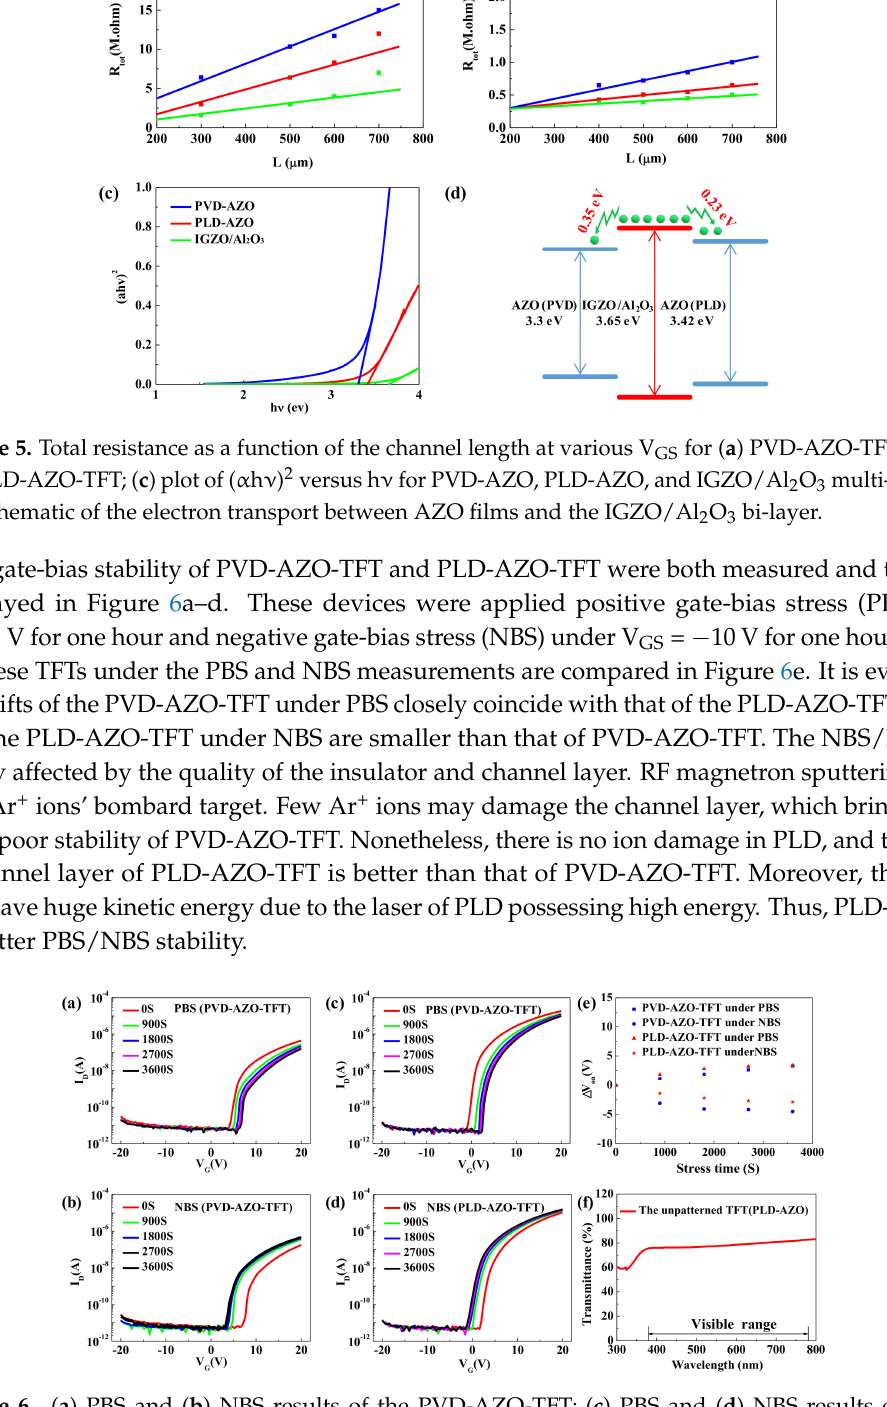
Figure 6. ( a ) PBS and ( b ) NBS results of the PVD-AZO-TFT; ( c ) PBS and ( d ) NBS results of the PLD-AZO-TFT; ( e ) the V on shift of the TFTs under PBS (VG = +10 V) and NBS (VG = − 10 V); ( f ) transmittance spectra in the wavelength range of 300 nm–800 nm for un-patterned